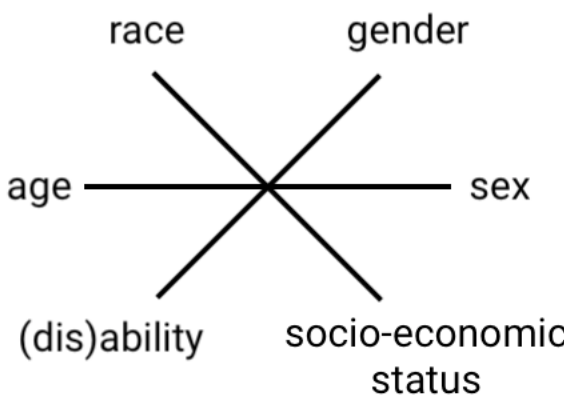
FIGURE 1. INTERSECTIONAL MAP TEMPLATE. THIS FIGURE SERVES AS A TEMPLATE FOR HOW TO CONSTRUCT ONE’S OWN MAP OF THE VARIOUS FACETS OF THEIR POSITIONALITY.